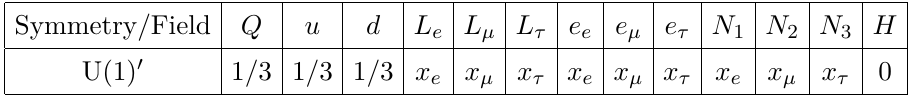
Table 1 . U(1) 0 charges of the model. The charges x α , with α = e, µ, τ , can take the values x α = 0 , − 1 , − 2 , − 3 , while the charges of the quarks are 1 / 3 . measurement, and B i ( B i ) is the beam-on (steady-state) background. The systematic un- on ss certainties of signal and background normalization are encoded in σ